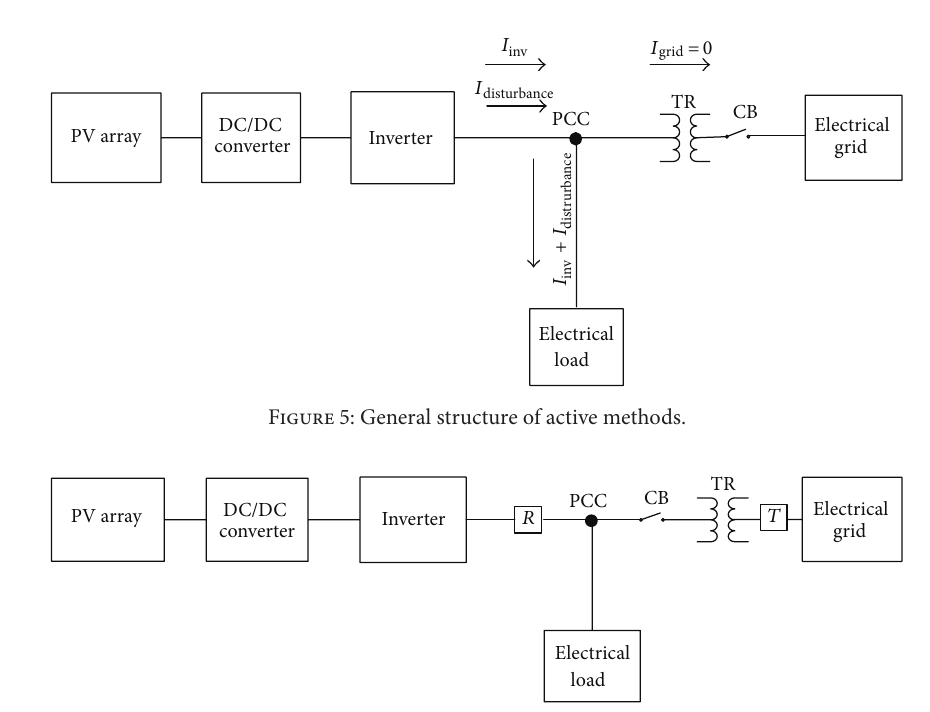
Figure 6: The general structure of communication based